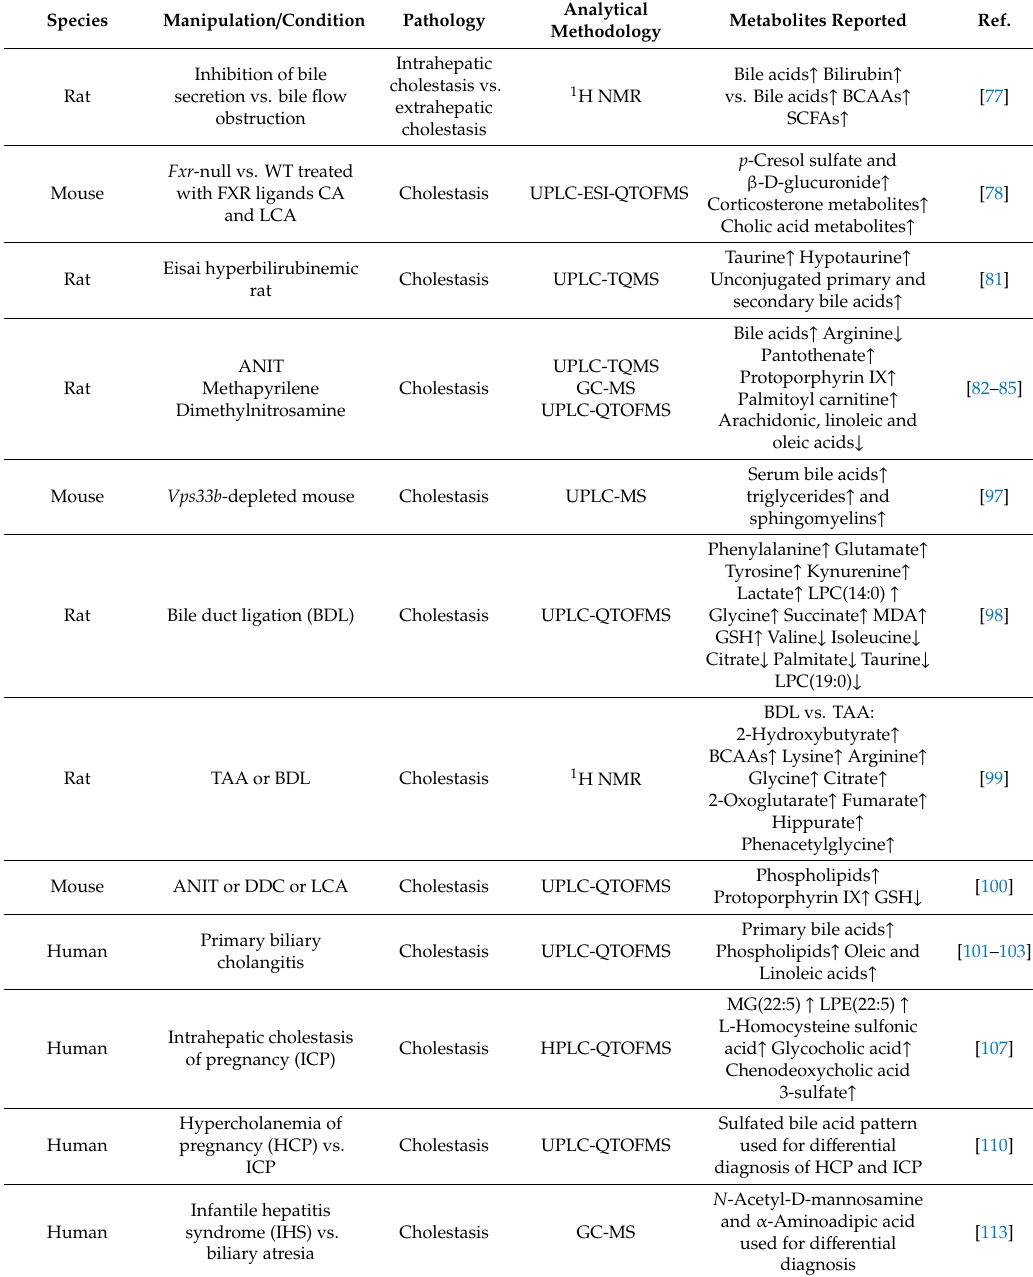
Table 2. Metabolomic and lipidomic biomarkers of